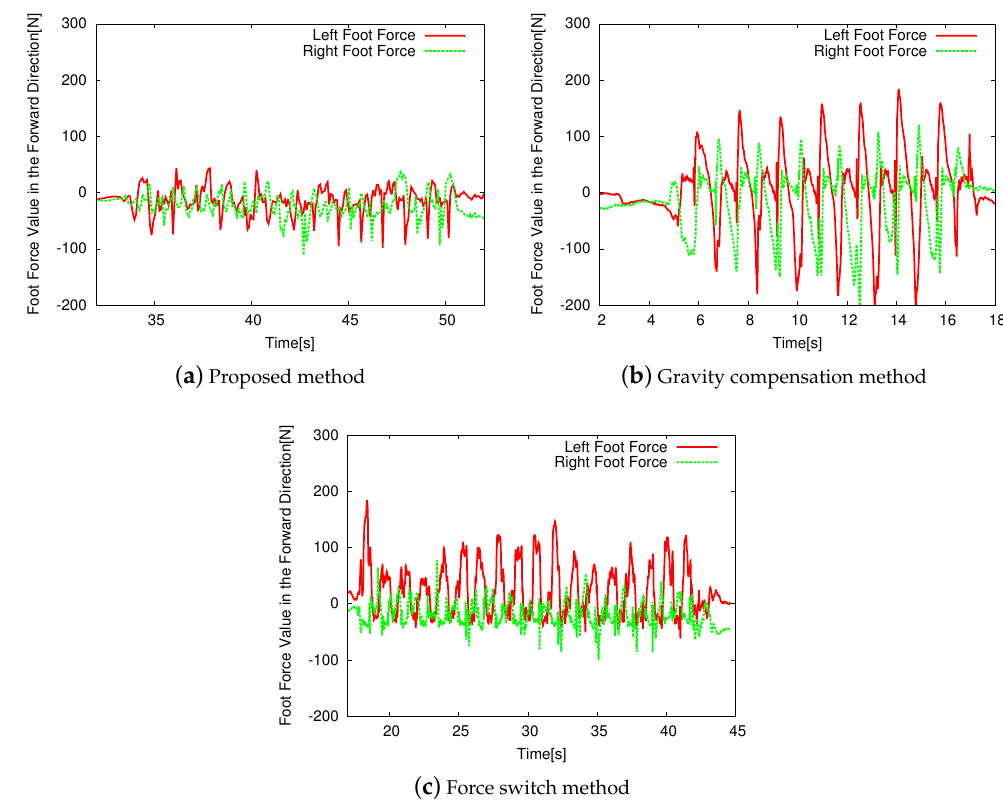
Figure 12. Reaction force on feet in horizontal front-back direction while walking backward based on each control